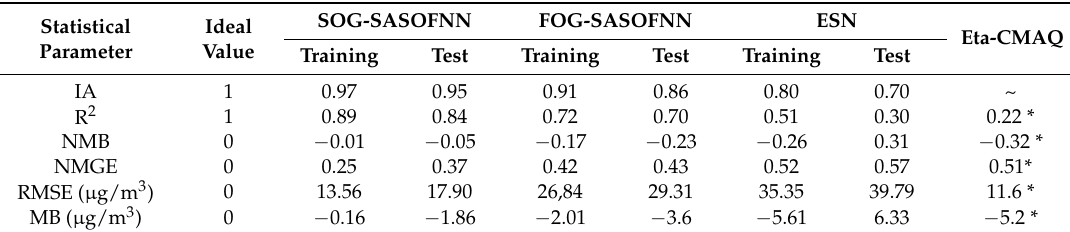
Table 4. Statistical performances of SOG-SASOFNN, FOG-SASOFNN, ESN and Eta-Community Multiscale Air Quality (Eta-CMAQ) Multiscale Air Quality (Eta-CMAQ) model.